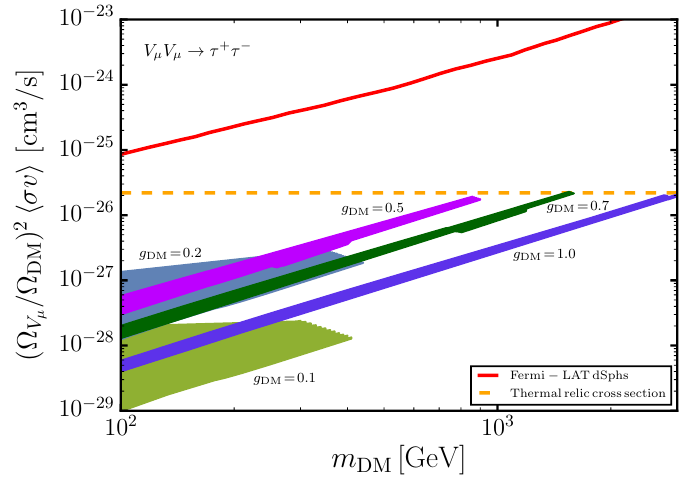
+ (cid:28) (cid:0) as a function of the dark (cid:22) V (cid:22) ! (cid:28) (cid:28) + (cid:28) (cid:0) process. The ! and (cid:1) M is scanned over the DM